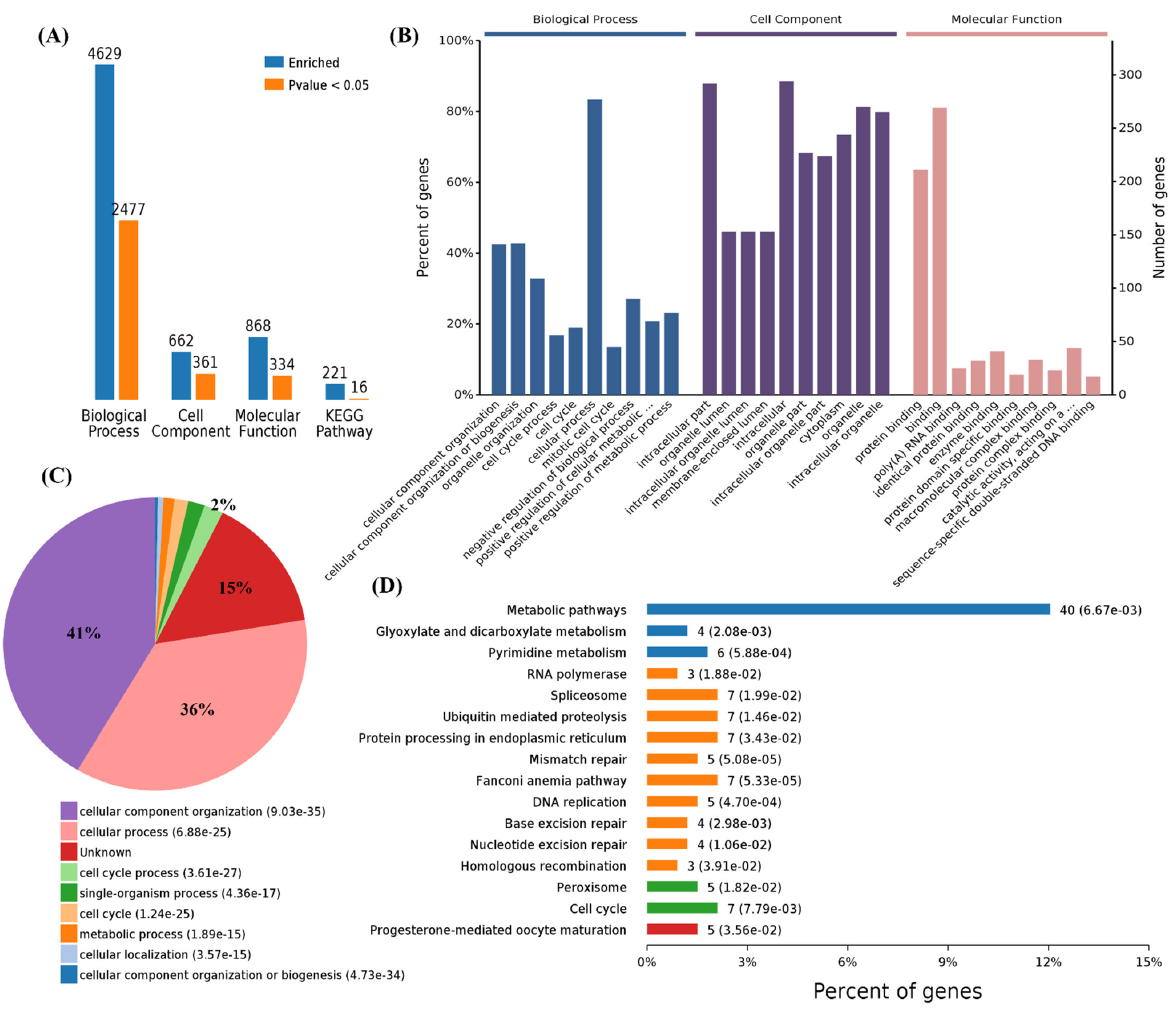
Figure 3. Functional enrichment of 340 commonly downregulated mRNAs among infected groups. ( A ) Number of commonly differentially expressed genes enriched in GO terms and KEGG pathways, blue represents all enriched GO terms, and orange represents significantly enriched GO terms, p < 0.05. ( B ) Overview of the significantly enriched biological process, cell component, and molecular function of the commonly downregulated genes. ( C ) Pie chart of an enriched biological process of the commonly downregulated genes. ( D ) Percentage of commonly downregulated genes associated with enriched KEGG pathways.